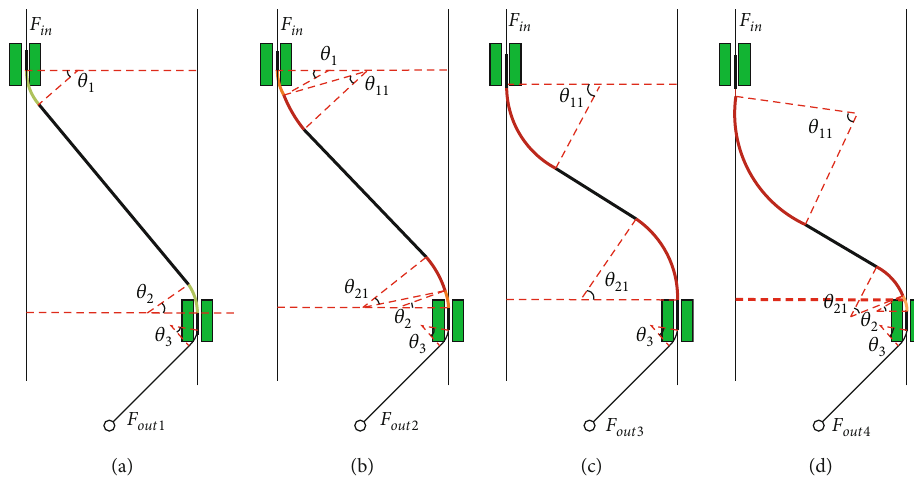
Figure 8: Changing process with various lengths of Bowden cable. (a) The Bowden cable mode with the angle θ Bowden cable mode with the angle θ cable mode with the angle θ